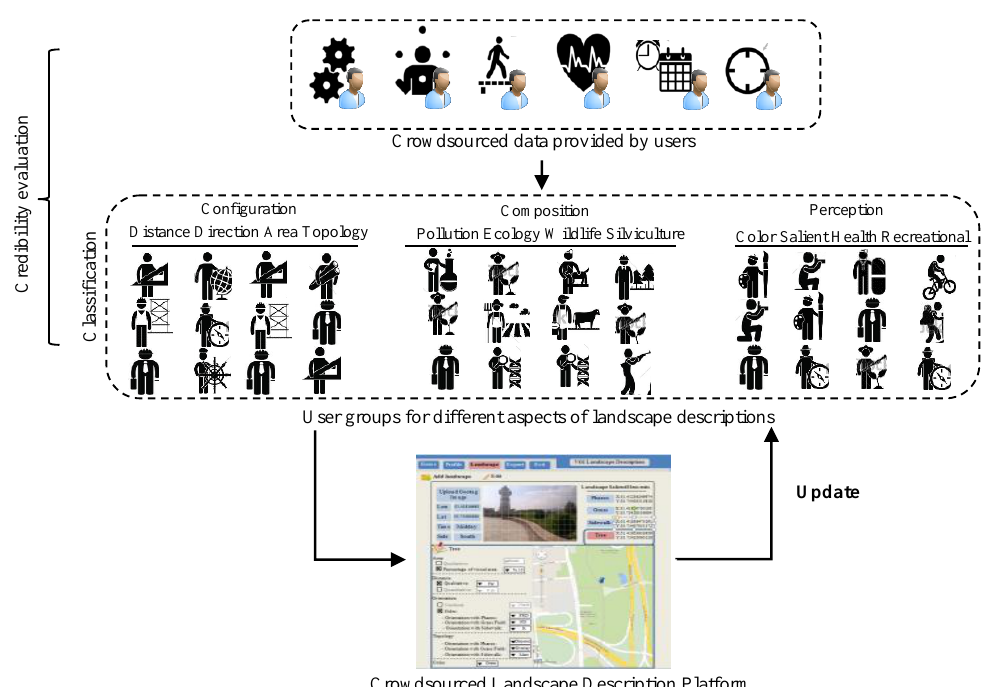
Figure 3. The proposed approach to include the users’ semantics in landscape